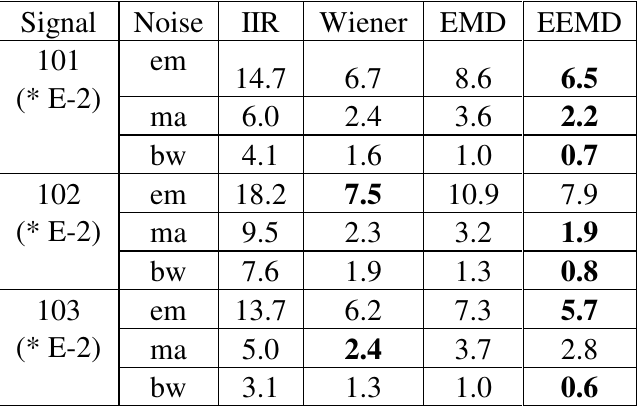
Table 3. MSE result of real ECG of four filter methods with three real noises. Minimum MSE of the same noise are mark